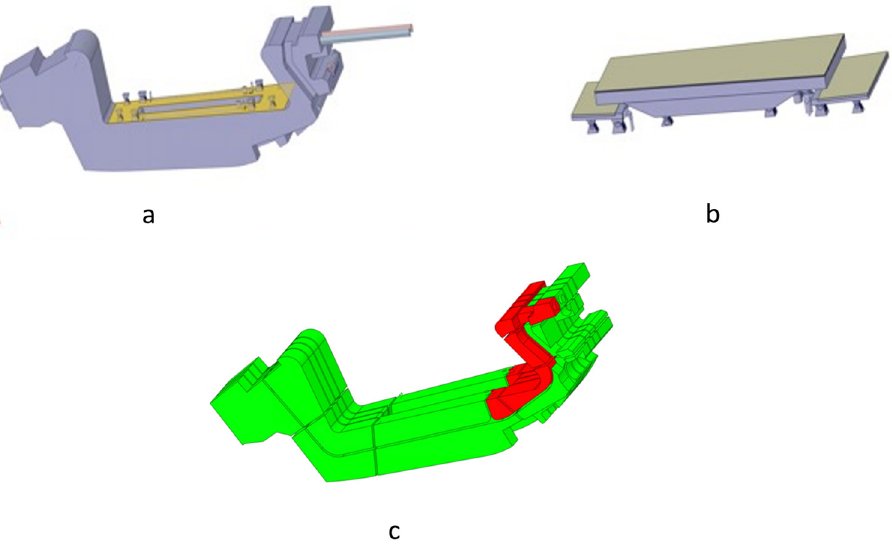
Figure 2. Divertor cassette body ( a ), cassette liner ( b ) and reflector plates (lateral) ( b ), Cassette Body-A (red) and Cassette Body-B (green) volumes ( c ).